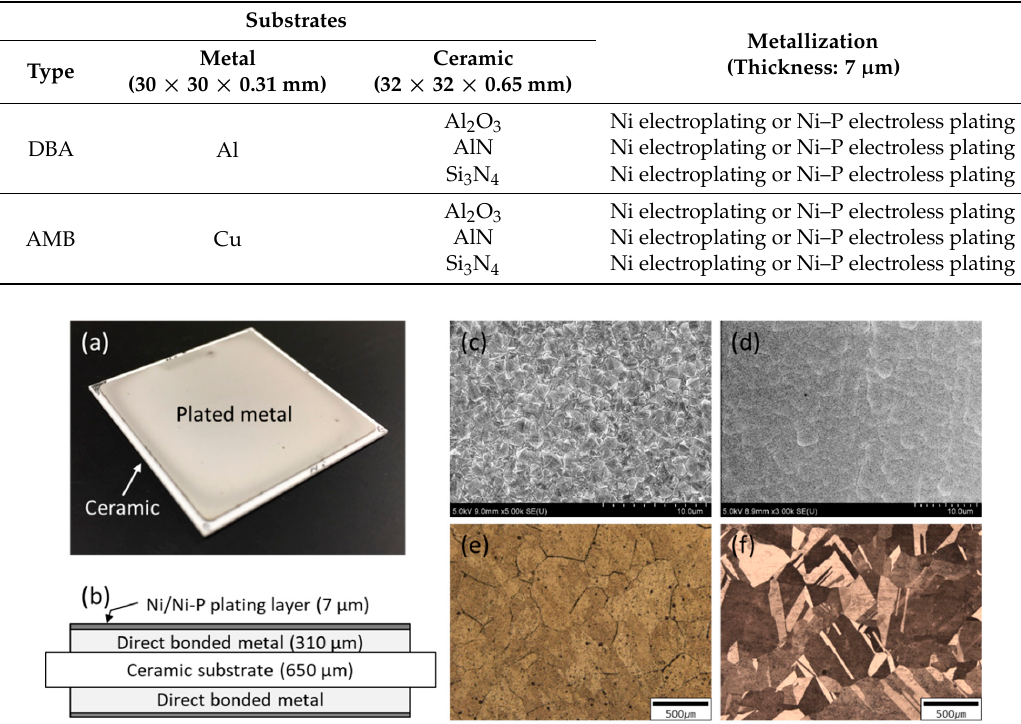
Table 1. Materials and dimensions of multilayered specimens.